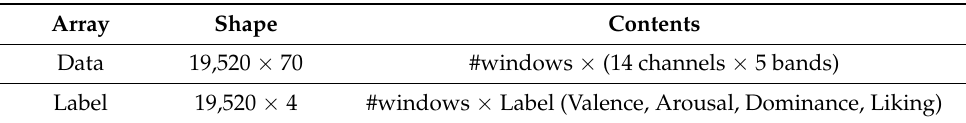
Table 5. Individual array size of data and label arrays after applying FFT using 14 channels and 5 bands.